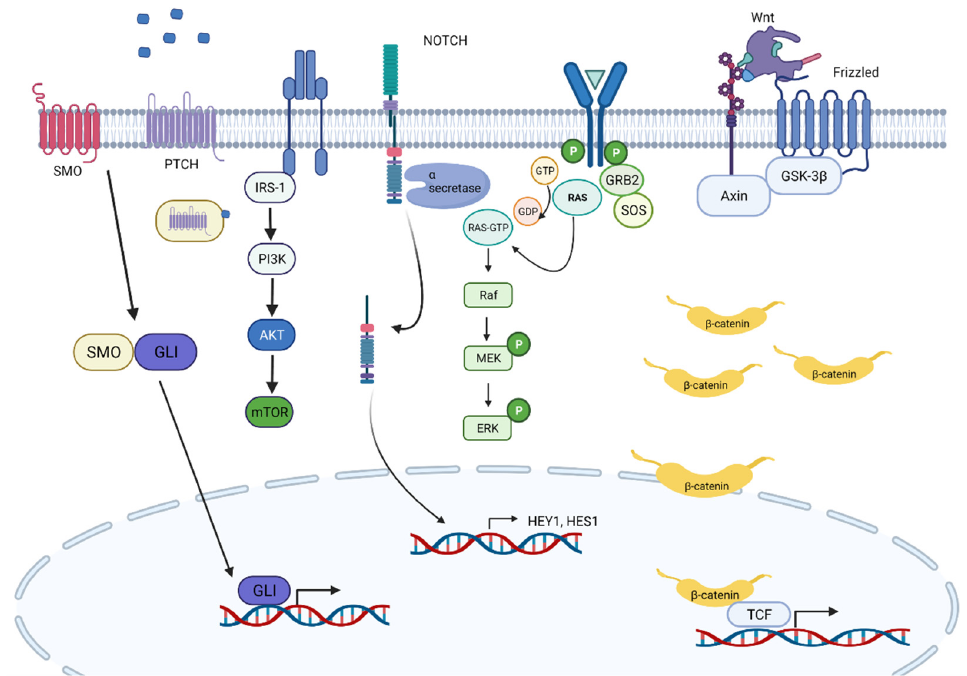
Figure 3. Overview of important signaling pathways in FN-RMS pathogenesis.